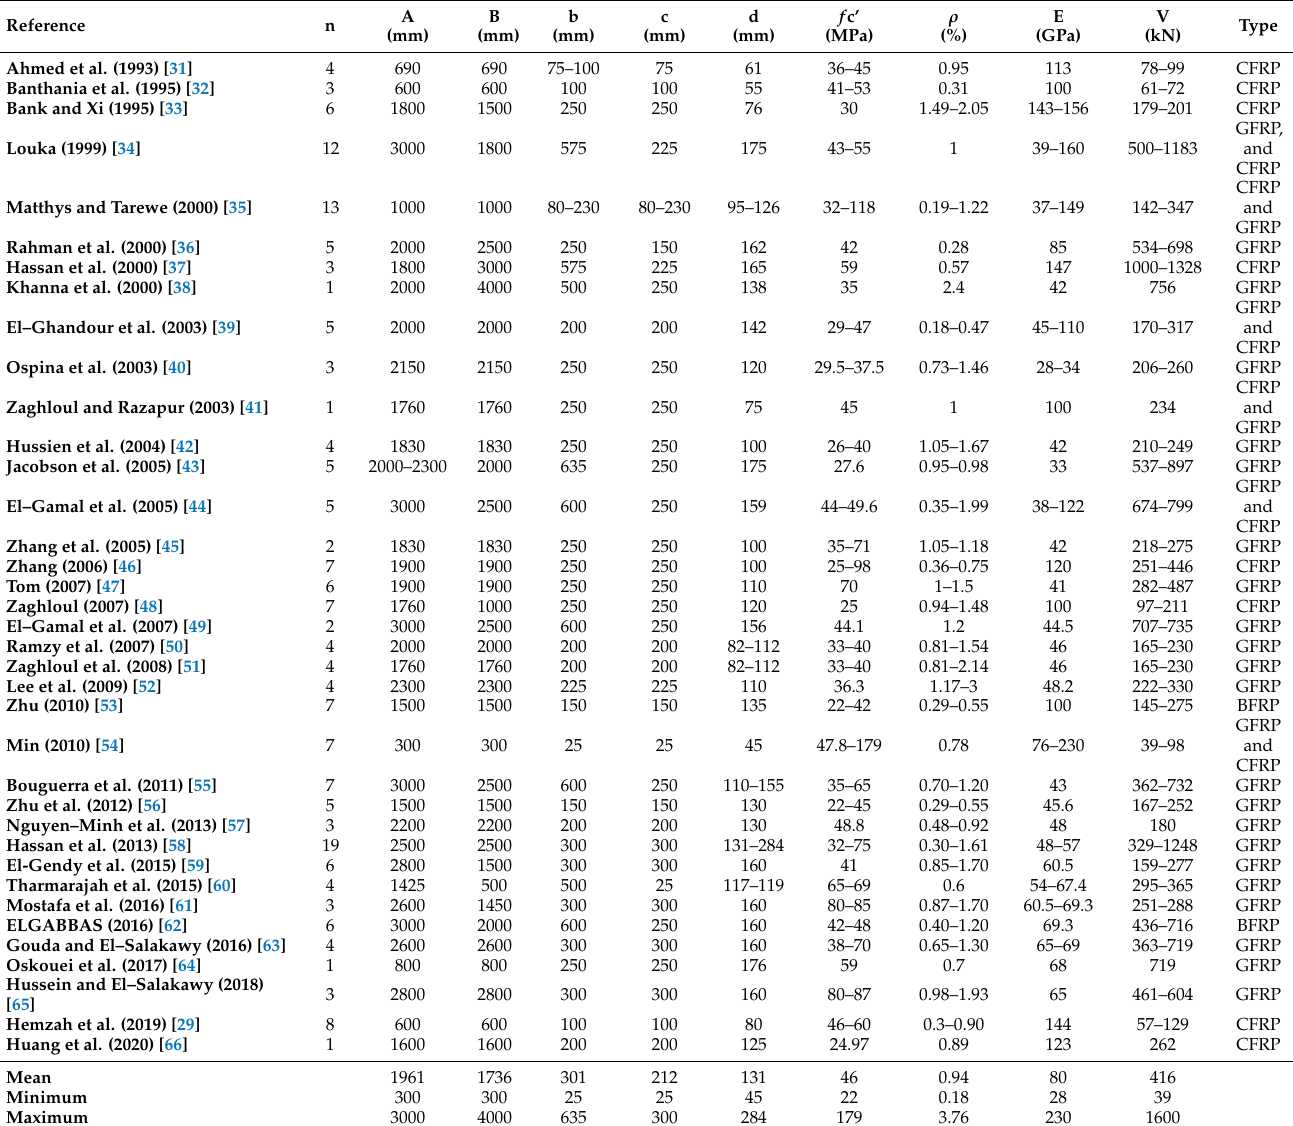
Table 2. Experimental database for FRP-reinforced concrete slab-column